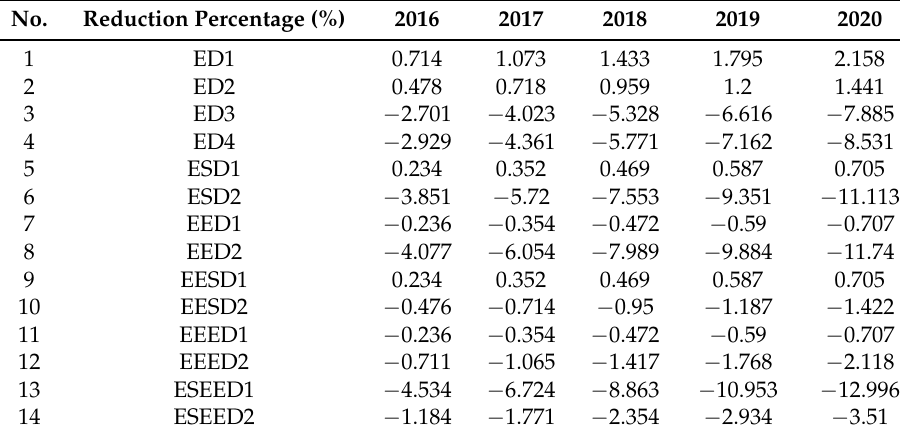
Table 8. Values of relative reduction rate for different scenarios (2016–2020)